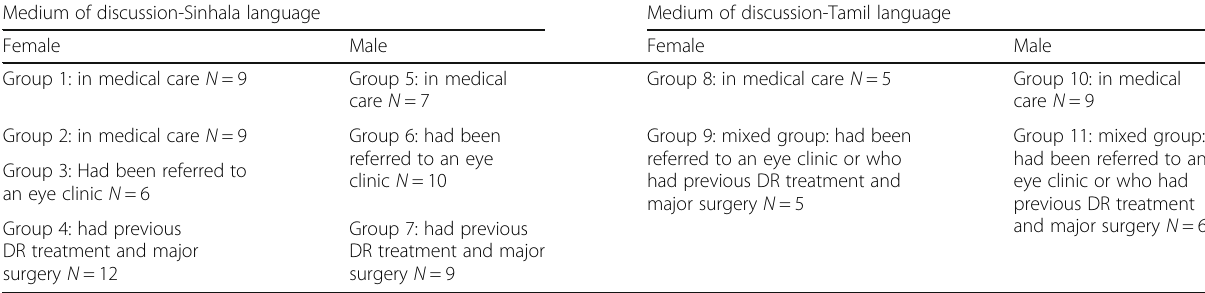
Table 1 Composition of focus groups